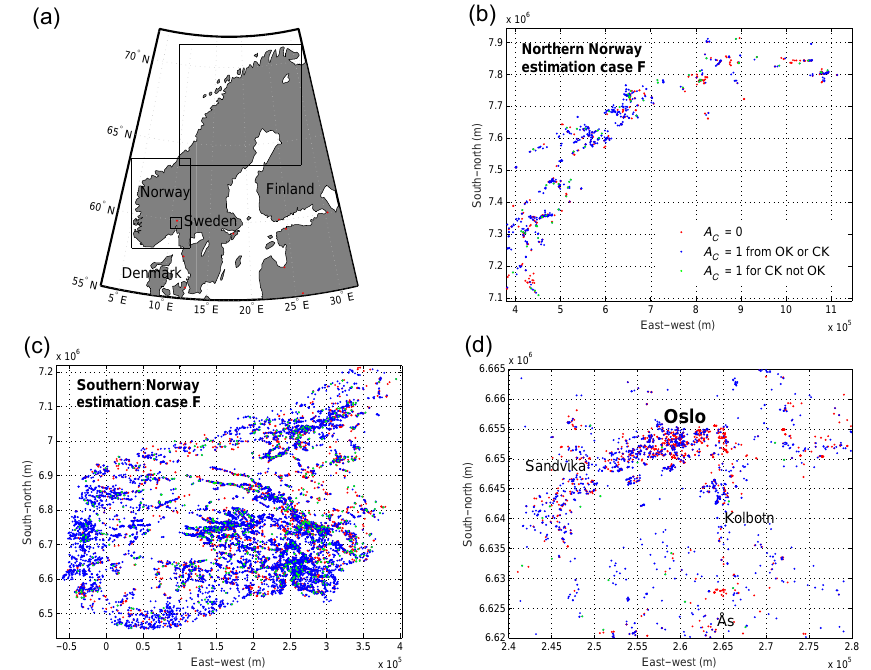
Figure 10. Outline of the Scandinavian countries (a) . The boxes indicate the subsections of Norway: northern Norway (b) , southern Norway (c) , and the Oslo region (d) . The cross-validation results of G RANADA boreholes (NGU, 2016a) for case F (Tables 3 and 4). For this case, 37% of the locations did not fulfill the accuracy criteria (Eq. 28) indicated by the red dots ( A C = 0); 63% of the locations did fulfill the accuracy criteria by either the OK or CK method, indicated by the blue dots ( A C = 1 from OK or CK)); for 3.5% of the locations the accuracy criteria were fulfilled by the CK method and not the OK method, indicated by the green dots ( A C = 1 for CK, not OK)). For 9.2% of the locations the accuracy criteria were met by the OK method only (not shown). Geographical coordinates are given for UTM zone 33.